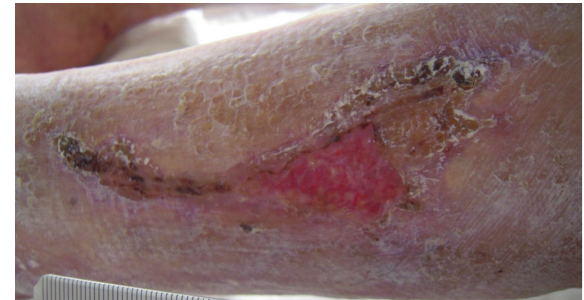
Figure 2: Skin ulcers progressively shrinkaged toward healing after 40 days of withdrawn